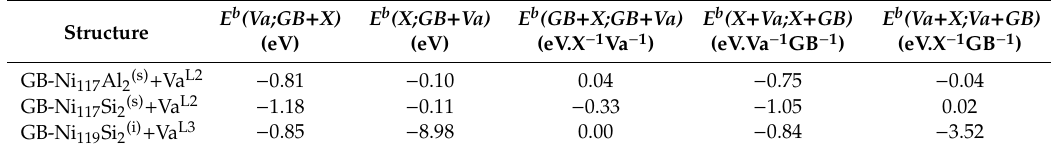
Table 8. The energetic characteristics of interaction of three defects: the binding energy of a vacancy to the couple of GB + X ( E b (Va;GB + X) ), the binding energy of an impurity to the couple of GB + Va ( E b (X ; GB + Va) ), the vacancy-impurity binding energy at the GB for substitutional or interstitial impurity ( E b (GB + X (s / i) ; GB + Va) ), the vacancy-GB binding energy in the presence of substitutional or interstitial impurity ( E b (X (s / i ) + Va;X ( s / i ) + GB) ), the X-GB binding energy in the presence of Va ( E b (Va + X ( s / i ) ;Va + GB) ) for GB-Ni 117 Al 2(s) + Va L2 , GB-Ni 117 Si 2(s) + Va L2 and GB-Ni 119 Si 2(i) + Va L3 structures. E b (Va;GB + Structure